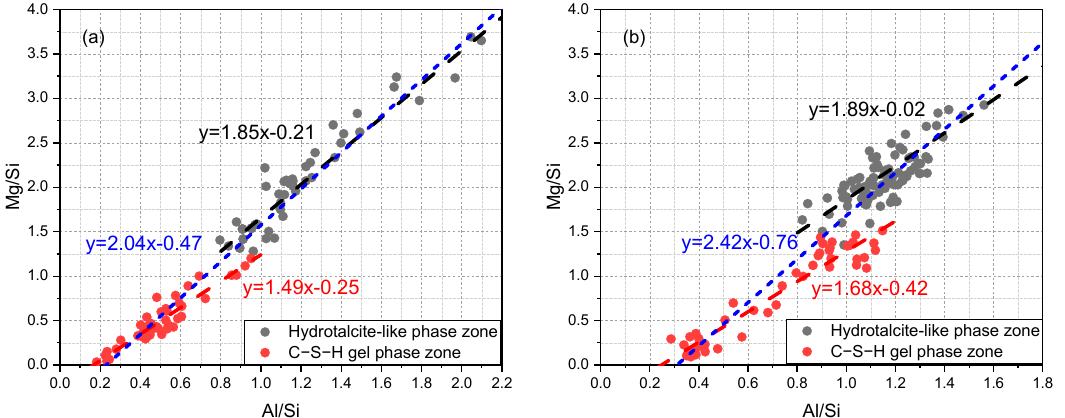
Figure 6. The scatter plots of Mg/Si vs. Al/Si in the molar ratio of ( a ) sample A and ( b ) sample B, respectively.